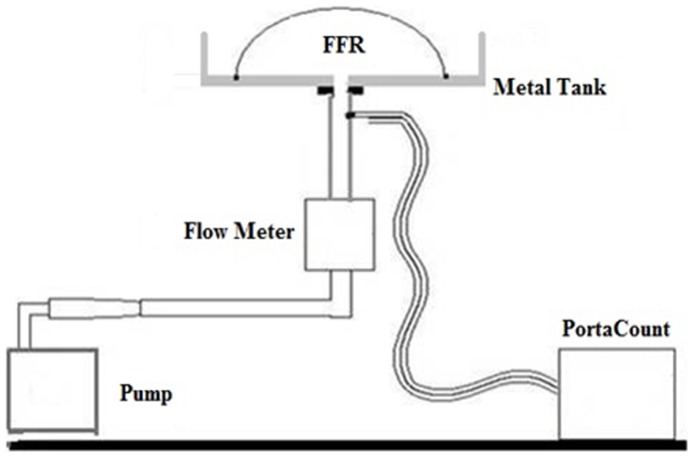
The schematic diagram of filter penetration measure equipments.